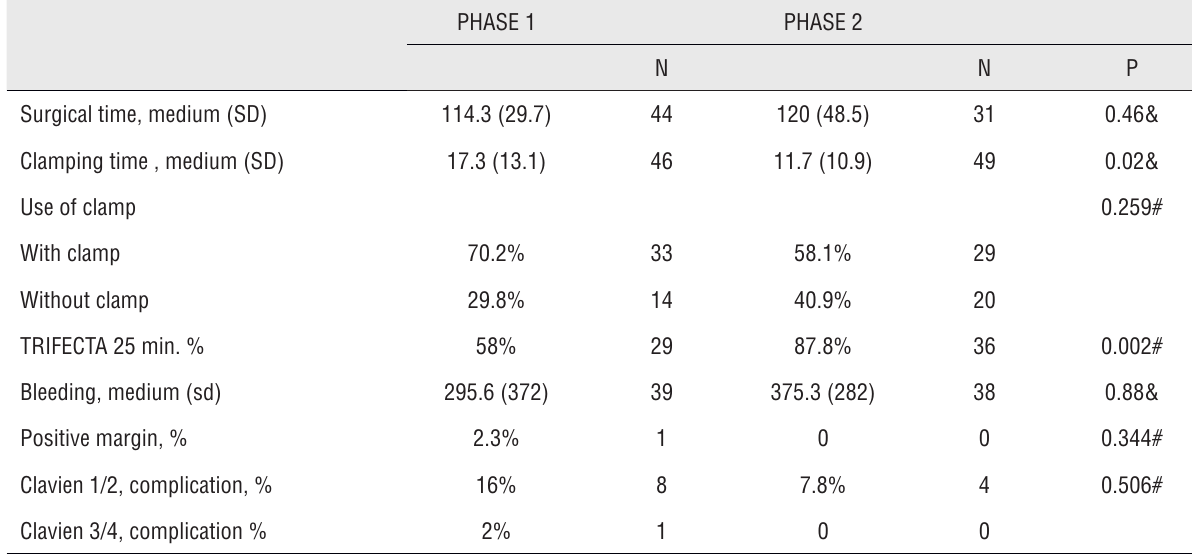
Table 3 - Peri-operatory data.